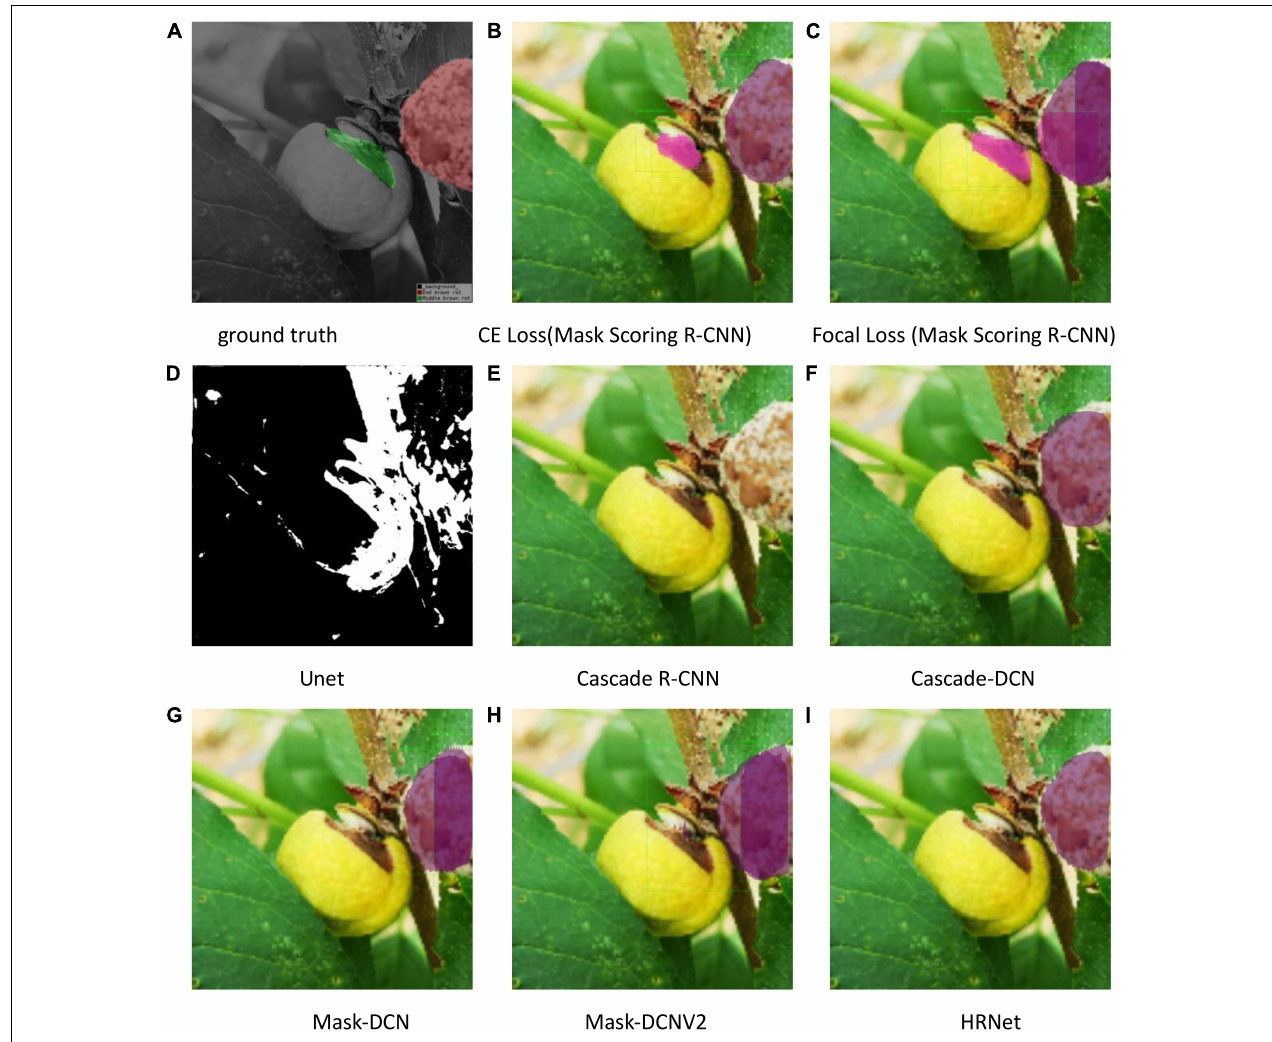
FIGURE 9 | Test results of different methods. (A) Ground truth, (B) CE Loss on Mask Scoring R-CNN, (C) Focal Loss on Mask Scoring R-CNN, (D) Unet, (E) Cascade R-CNN, (F) Cascade-DCN, (G) Mask-DCN, (H) Mask-DCNV2, and (I)